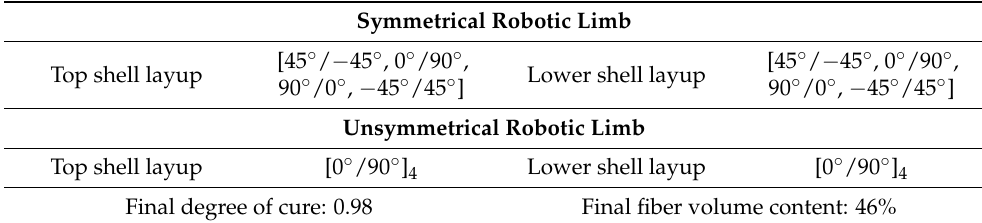
Table 2 . Layup scheme of the robotic limb. Table 2. Layup scheme of the robotic